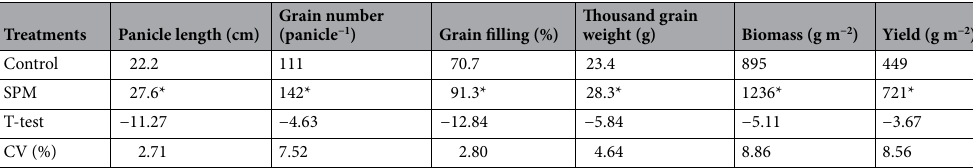
Table 5. Effect of spermine on panicle length, grain number, grain filling, thousand grain weight, biomass and yield in MADA. T-test was performed at P ≤ 0.05. *: Significant at P ≤ 0.05. MADA: Muda Agricultural Development Authority. CV: Coefficient of variation.